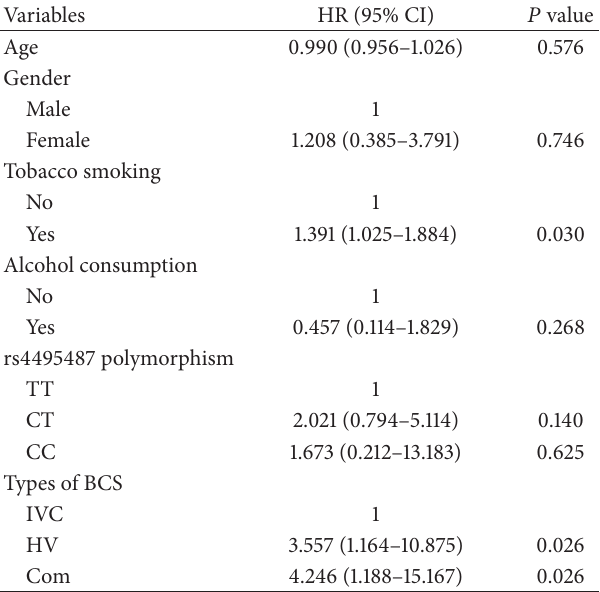
Table 4: Cox multivariate regression analysis of potential factors for overall survival in BCS